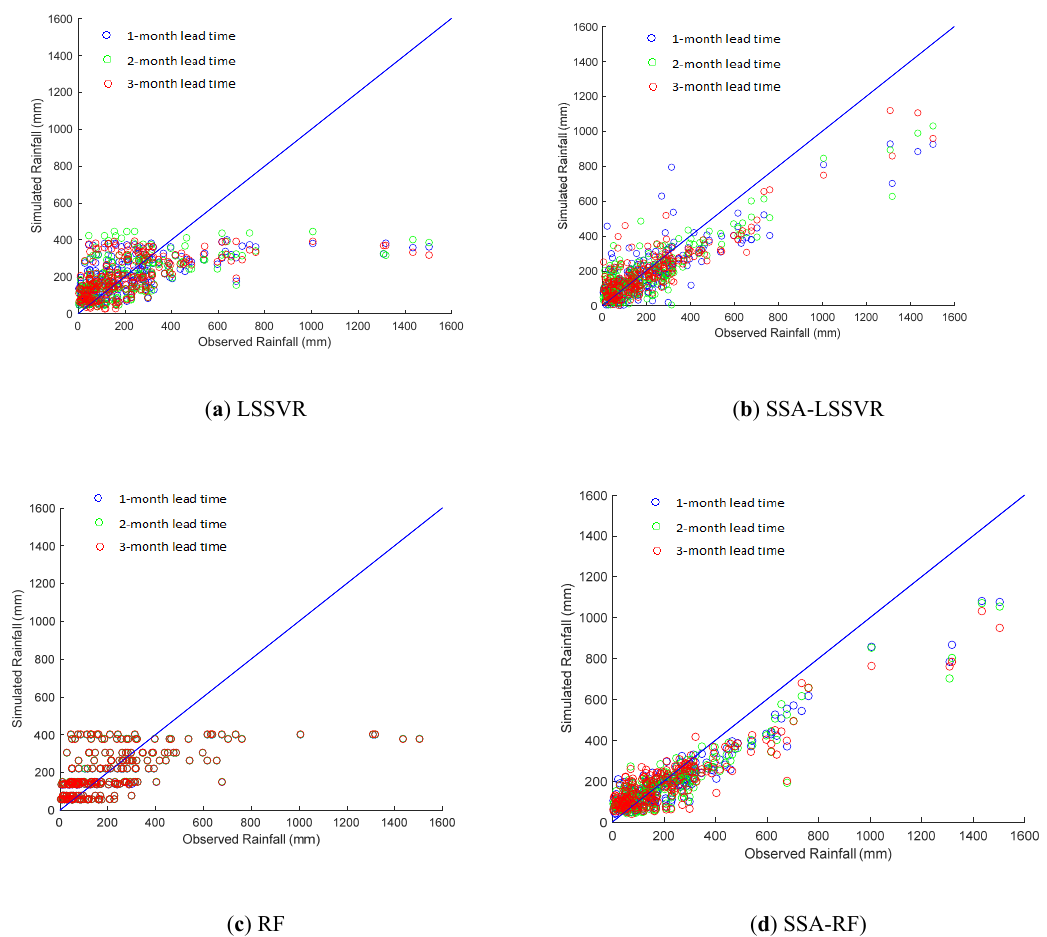
Figure 6. Scatterplots of the observed vs. forecasted rainfalls by the ( a ) LS-SVR, ( b ) SSA-LSSVR, ( c ) RF, and ( d ) SSA-RF models during the validation period for Shihmen reservoir watershed 1-,2-, and 3-month lead time.